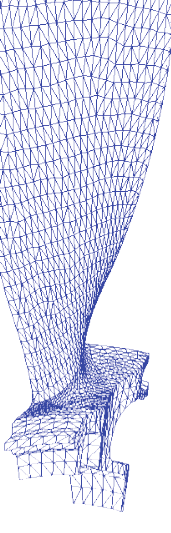
Figure 1: FE model of the blisk.